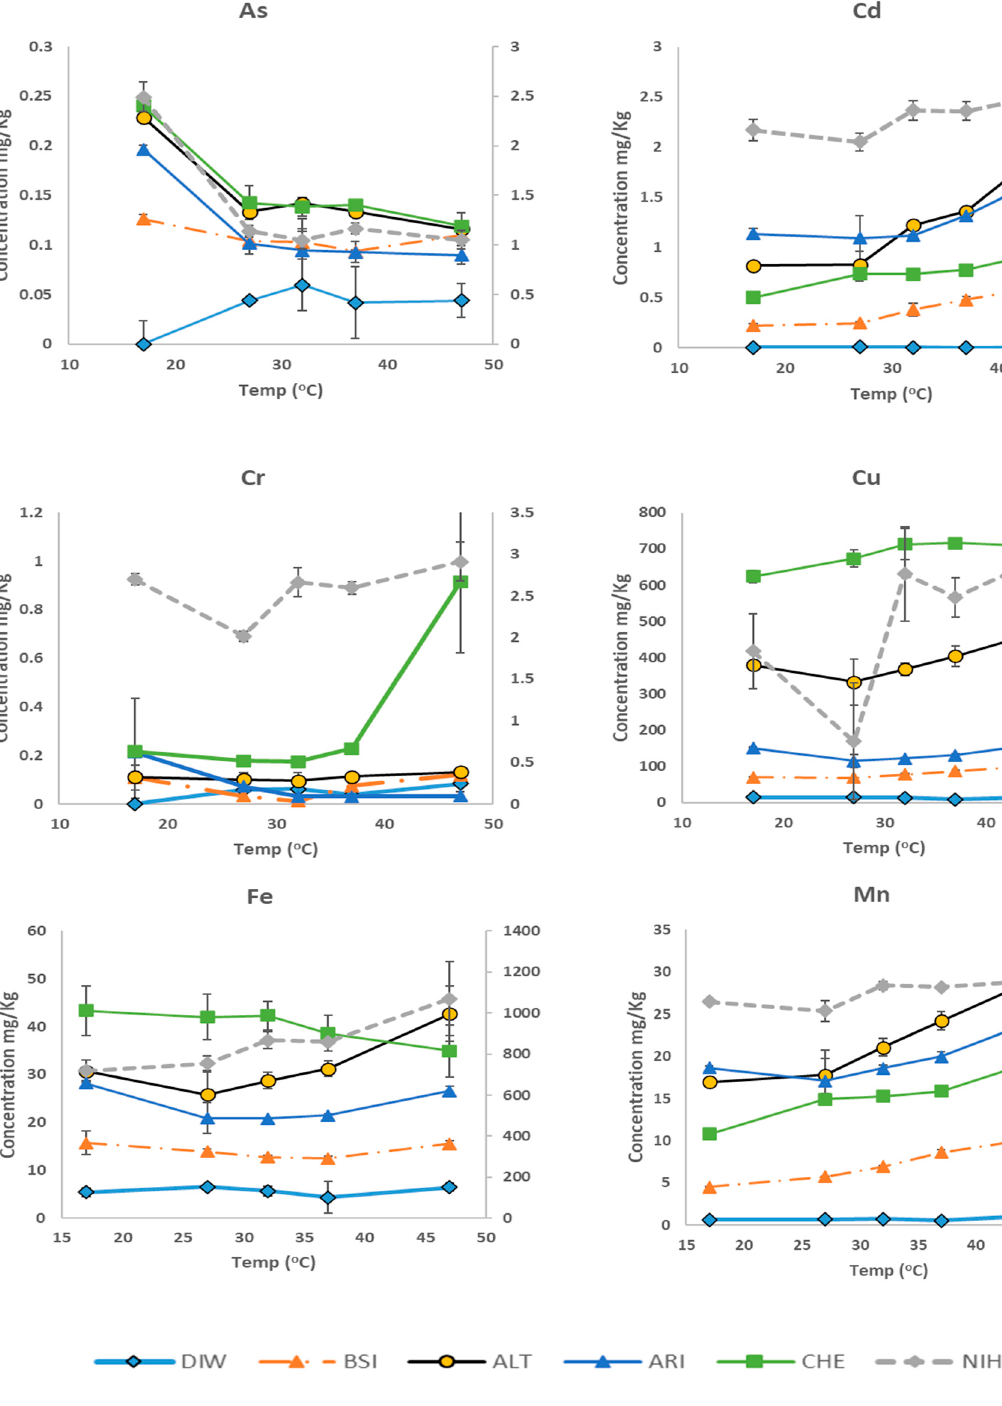
Figure 2. Dermal bioaccessible concentrations of As, Cd, Cr, Cu, Fe and Mn in bulk composite soil sample using different artificial sweat solutions and extraction temperatures. Results are plotted against the primary ( left-hand ) axis except NIHS, which is plotted against the secondary ( right- hand ) axis.